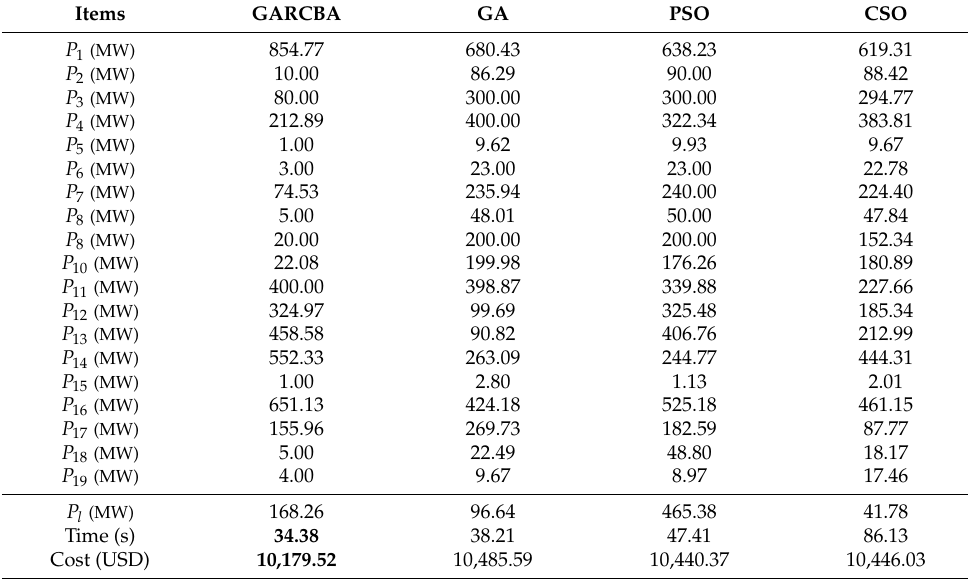
Table 3. Best cost solutions for Case 1.1 from 25 runs.